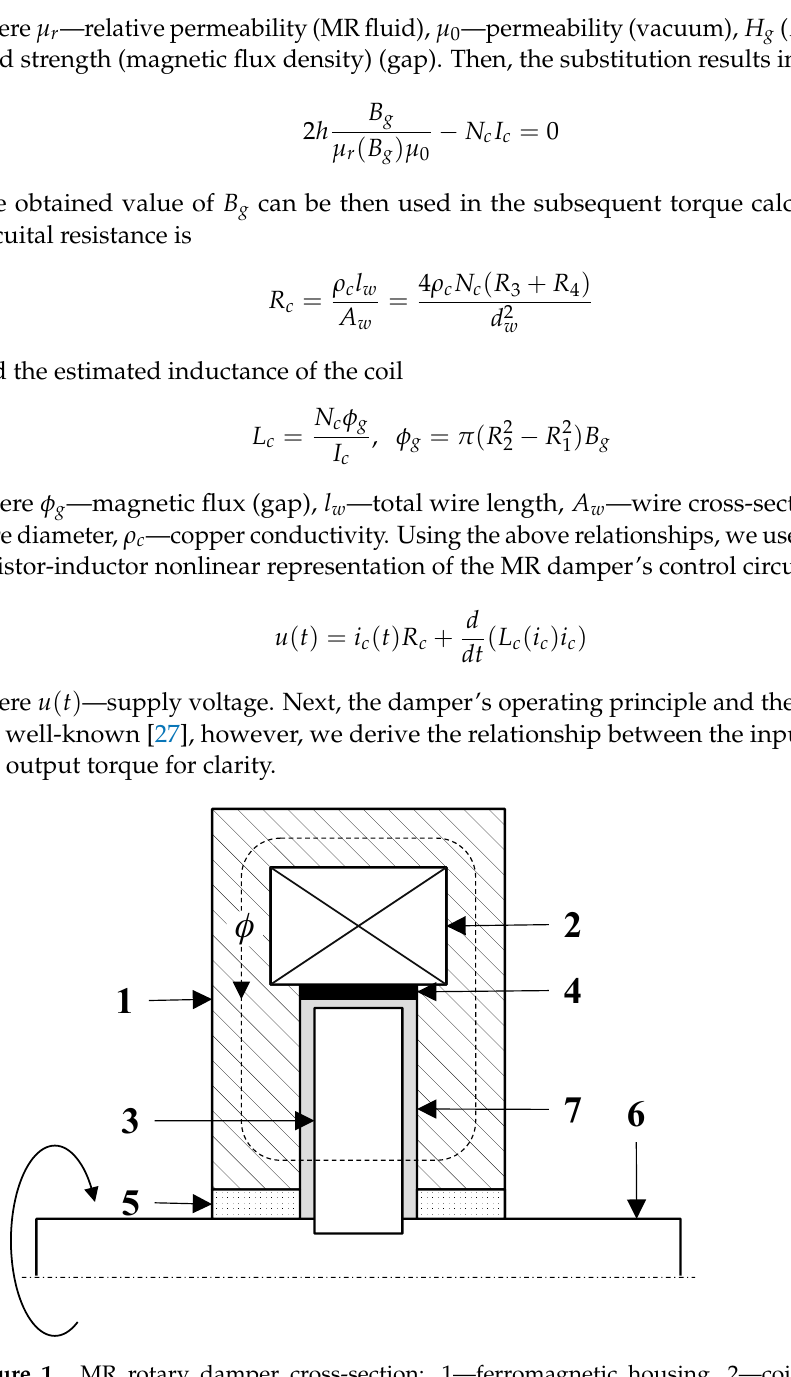
Figure 1. MR rotary damper cross-section: 1—ferromagnetic housing, 2—coil assembly, 3— ferromagnetic shear plate, 4—non-magnetic ring, 5—bearings, 6—shaft, 7—MR